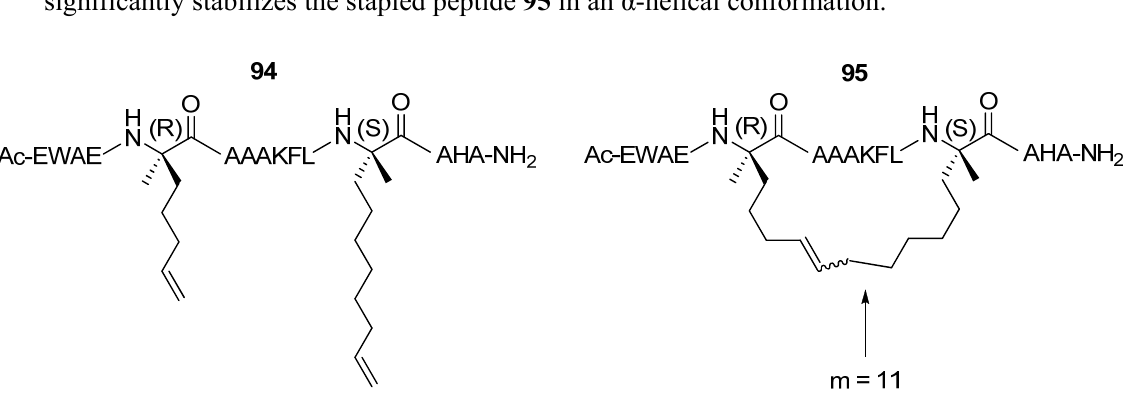
Figure 25. An 11-atom long all-hydrocarbon bridge between residues i and i+7 significantly stabilizes the stapled peptide 95 in an α -helical